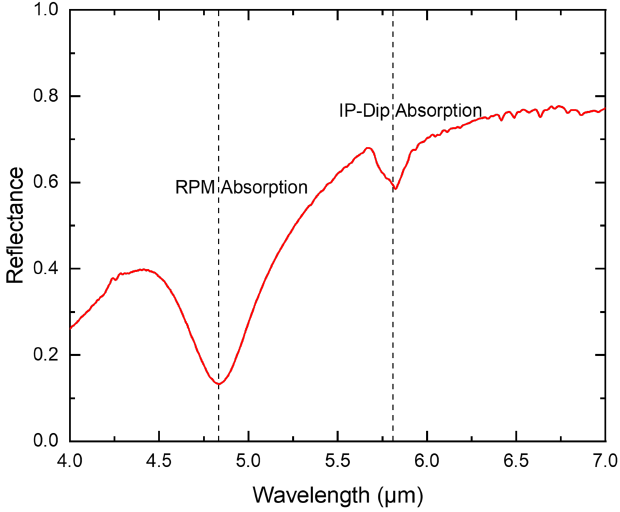
Figure 4. Experimental reflectance spectrum of the fabricated reciprocal plasmonic metasurface with- out any dielectric coating. The experimental data were obtained at 8.7 ◦ incidence with a polarization parallel to the long axis of the rectangular fins. The resonance of the reciprocal plasmonic metasurface can be observed at 4.8 µm. The absorption feature, located at 5.8 µm, is due to an absorption band in the dielectric spacer (see Figure 1)